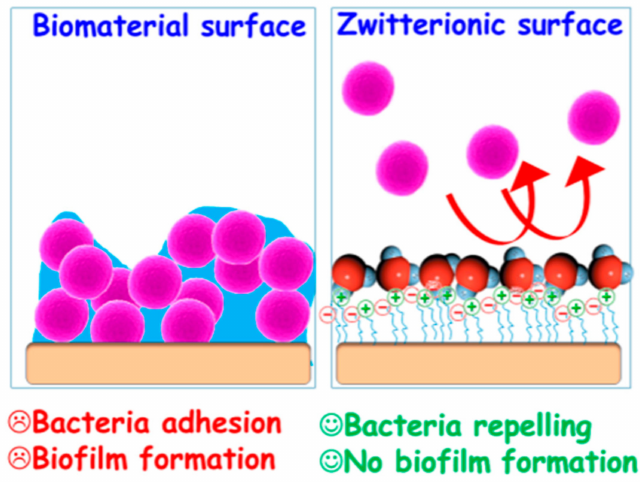
Figure 6. Schematic representation of bacterial colonization in standard surfaces vs. zwitterionic surfaces. Unlike in unmodified surfaces, zwitterionic materials create a hydration layer that prevents bacterial adhesion and biofilm formation. Reproduced from [40] with permission of MDPI,